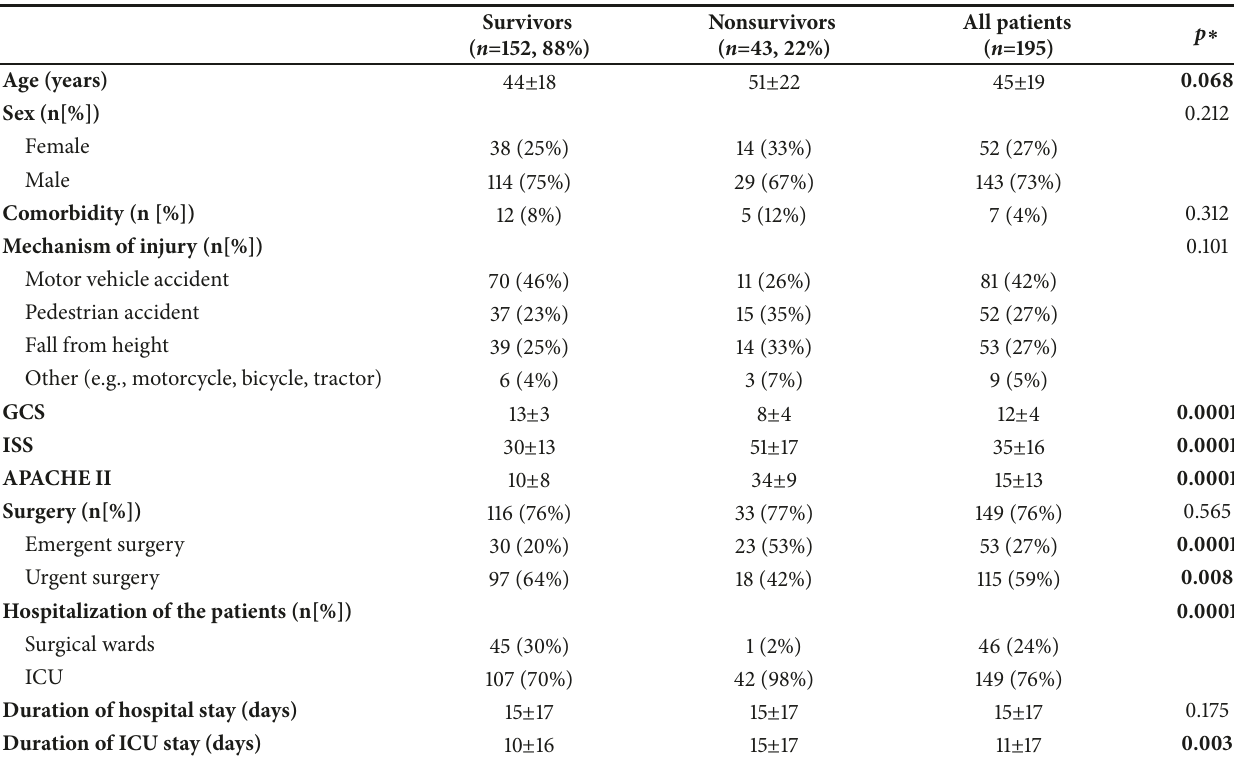
Table 1: Patients demographics, findings on initial evaluation, and hospitalization.